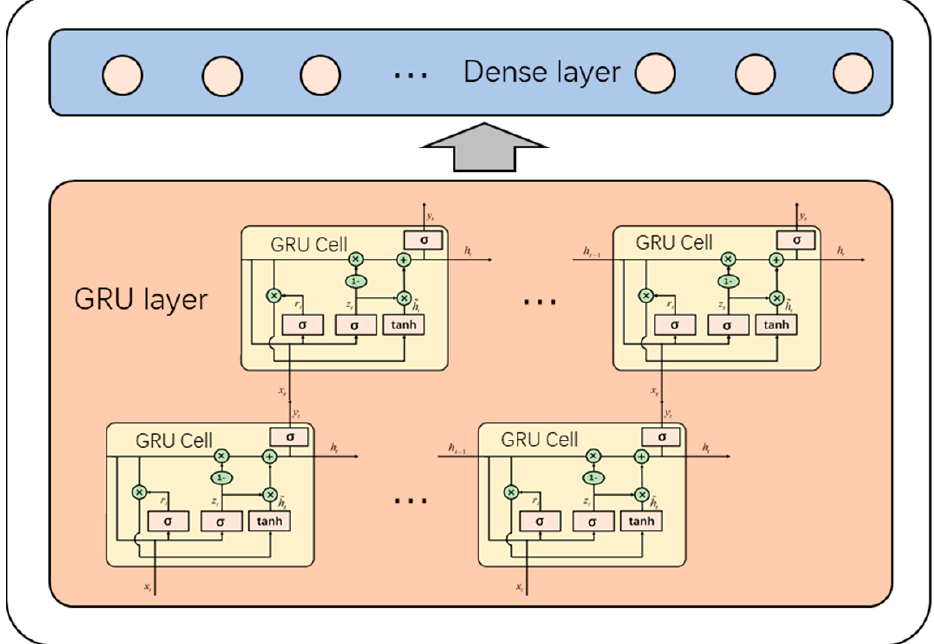
Figure 2. The network